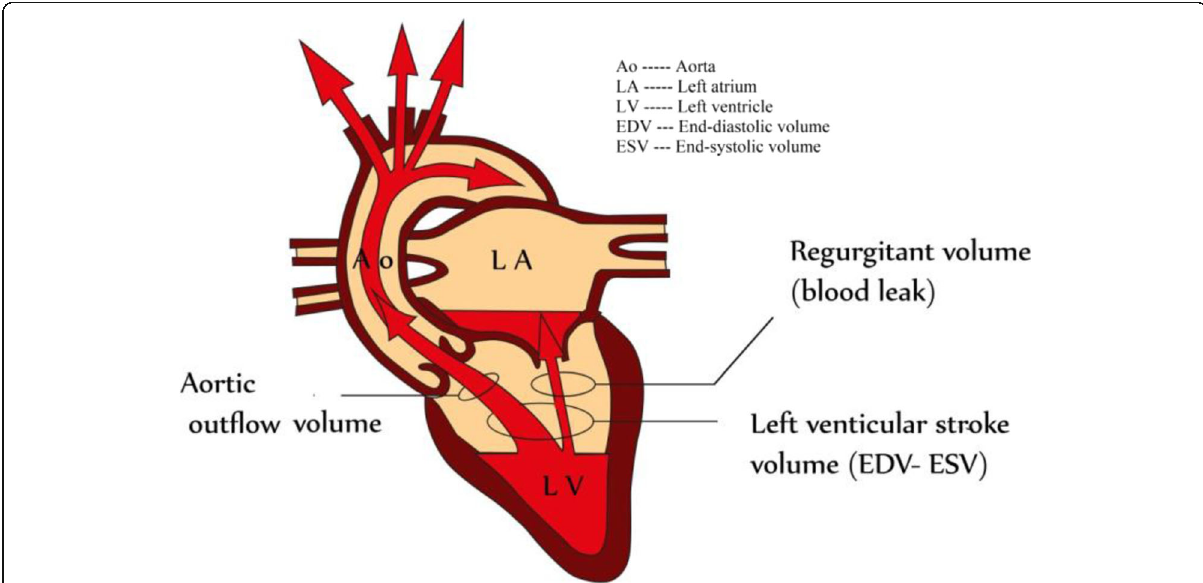
Fig. 1 In mitral valve regurgitation, the blood leaks backward during systole through the mitral valve into the left atrium dividing the stroke volume estimated by volumetric method into two components: the aortic flow volume which represent the effective stroke volume, and the regurgitant flow volume which still present within the heart overestimating the calculated ejection